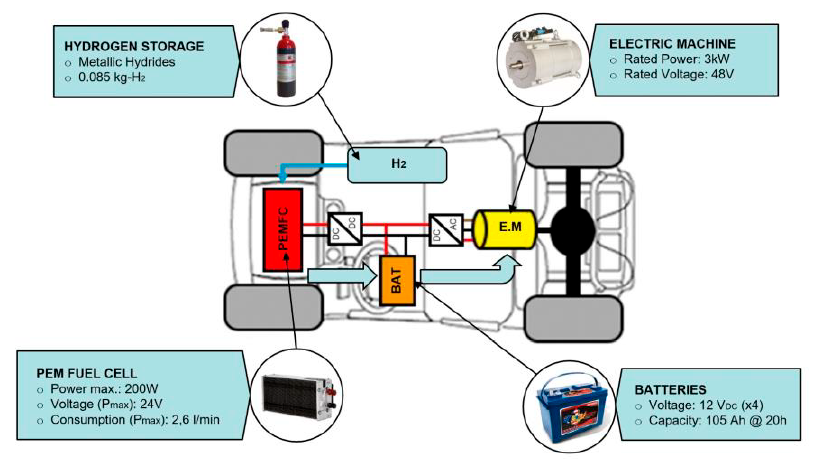
Figure 1. Configuration of the FCEREV.